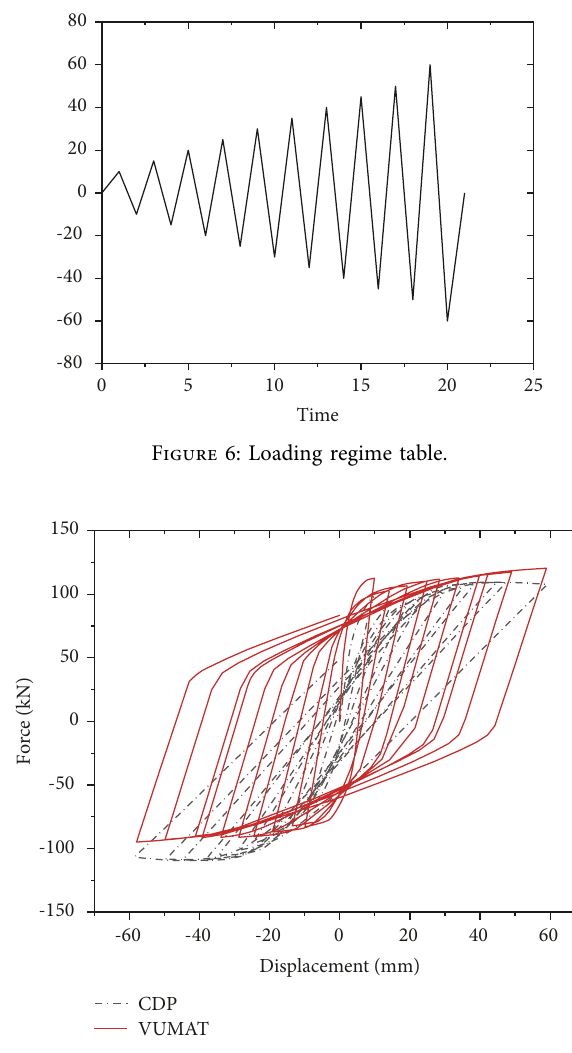
Figure 7: Hysteretic curve of reinforced concrete